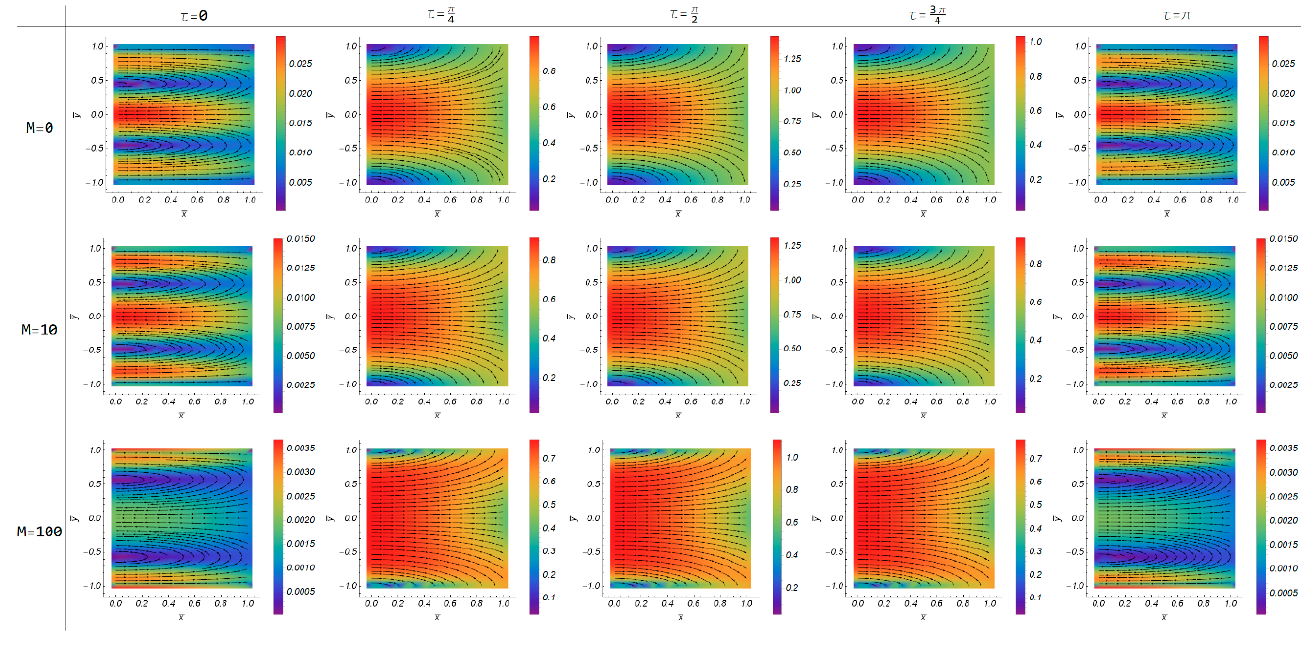
(cid:110) (cid:111) (cid:3095) , (cid:3095) , (cid:2871)(cid:3095) , 𝜋} , and Magnetic 0, π , π , 3 π , π , and 2 4 4 (cid:2872) (cid:2870) (cid:2872)